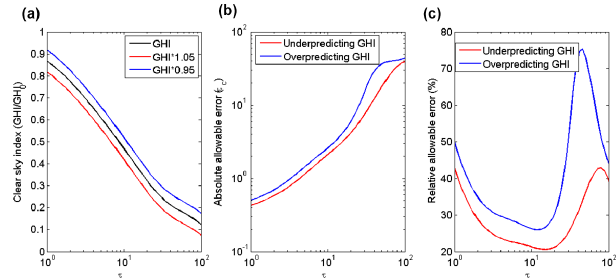
Figure 1. (a) GHI divided by clear-sky GHI as a function of τ c for homogenous clouds as derived from SHDOM. The black line represents the results while the blue and red are 5% offsets in clear- sky GHI. (b) Error bounds of ± 5% clear-sky GHI in (a) converted to absolute intervals for τ c . For example, for GHI to stay within 5% clear-sky GHI at τ c = 30, τ c cannot be more than 7.7 below 30 and not more than 15.6 above 30. (c) Same as (b) but the y axis is divided by τ c